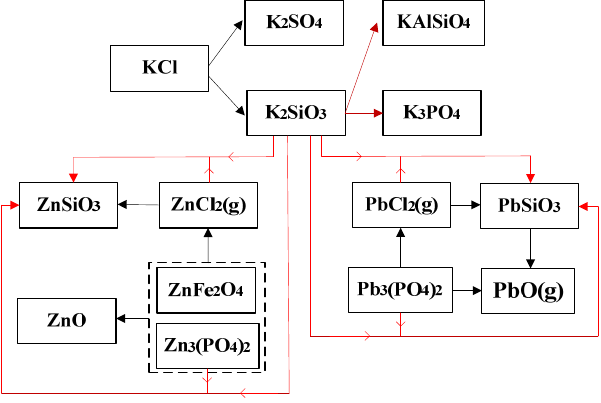
Figure 11. K, Pb, and Zn migration pathways in the combustion.